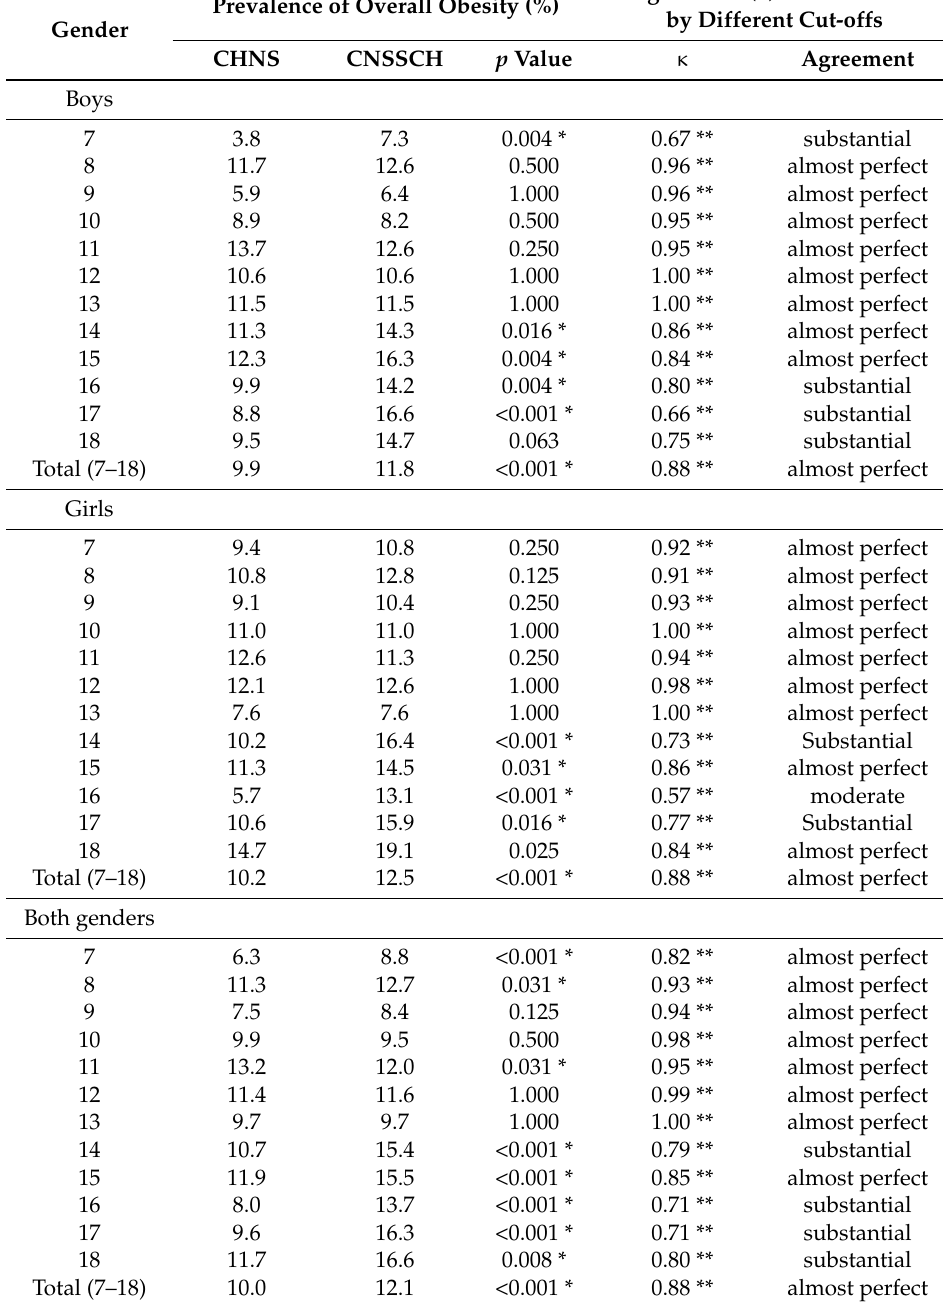
Table 5. Prevalence of abdominal obesity among Chinese boys and girls aged 7–18 years and the comparison based on the CHNS and CNSSCH